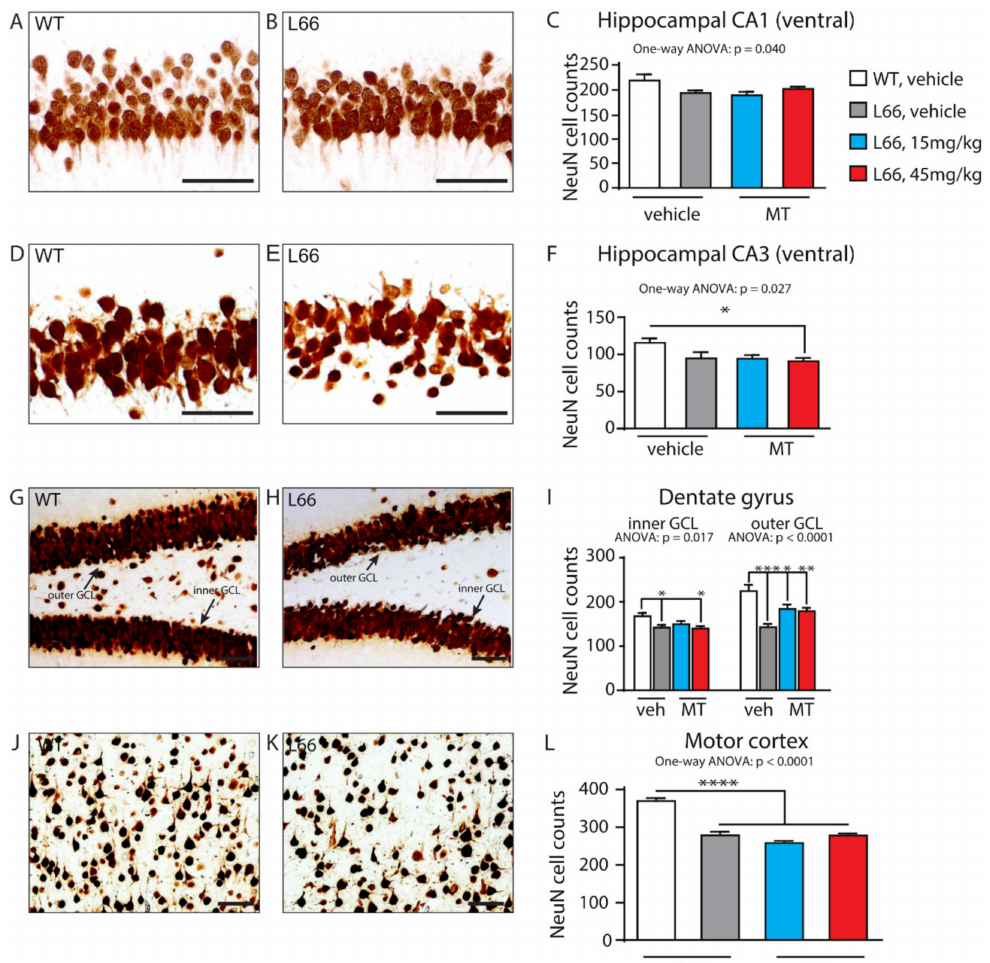
Figure 8. Neuronal cell counts between genotypes and in drug cohorts. Quantification of NeuN-immunoreactive neurons by manual cell counting in hippocampal CA1 ( A – C ), hippocampal CA3 ( D – F ), the inner and outer granule cell layers of the dentate gyrus ( G – I ), as well as in motor cortex ( J – L ) in wild-type ( A , D , G , J ) and L66 ( B , E , H , K ) mice. Loss of neurons in L66 mice was evident in hippocampal CA1 ( C , p = 0.040) and CA3 areas ( F , p = 0.027), in inner and outer GCL of the dentate gyrus ( I , p = 0.017 and p < 0.0001, respectively), as well as in the motor cortex ( L , p < 0.0001). LMTM did not reverse this cell loss in either area ( C , F , I , L ). Values are expressed as group mean ± S.E. Statistical analyses were conducted using one-way ANOVA and Bonferroni corrected t-test for n = 9–13 mice per group. *: p < 0.05, **: p < 0.01, ***: p < 0.001, ****: p < 0.0001 compared to vehicle-treated wild-type mice. WT: